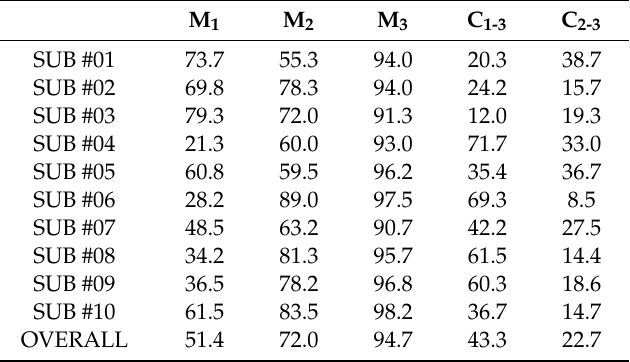
Table 2. The classification accuracy for all gestures with different experimental sessions.